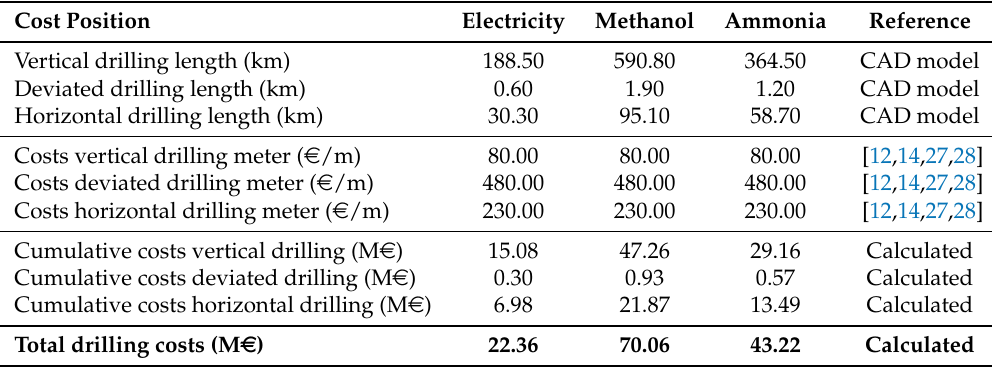
Table 3. Calculated drilling meters and resulting costs for injection and production wells for the onshore electricity, methanol, and ammonia production scenarios.